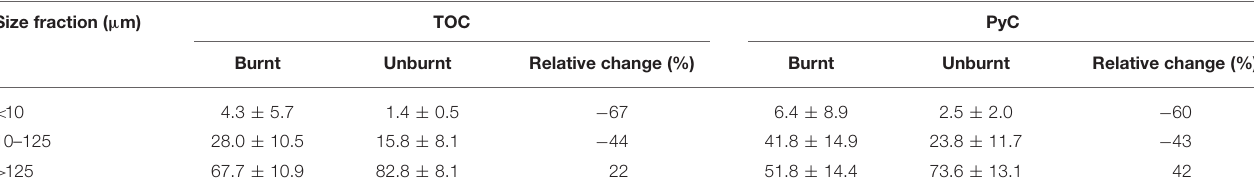
Values are averages and standard deviations. The relative changes in carbon contributions between treatments are also shown for each size fraction to obtain information about their distribution dynamics. TOC and PyC were determined from the mass of the material collected for each of the fractions, and their carbon content measured before and after the HyPy treatment. Unburnt quadrats had not experienced fire for at least two